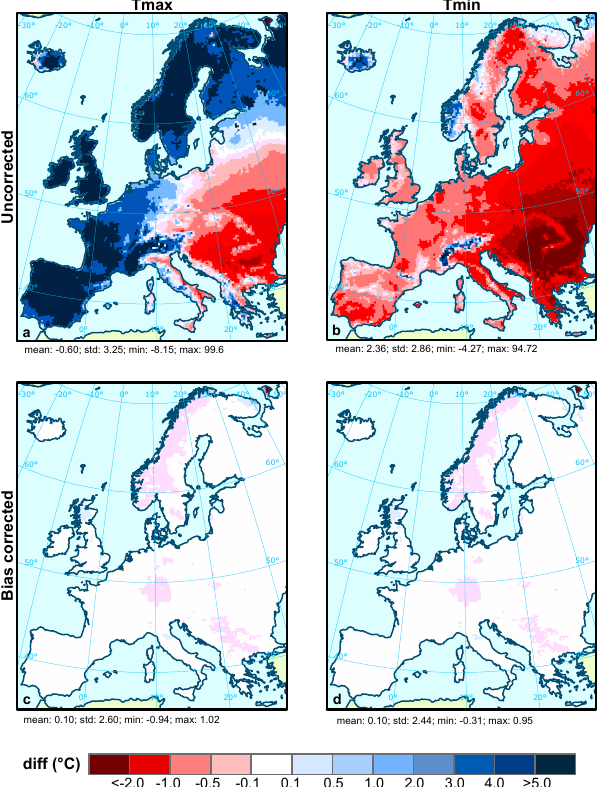
Fig. 7. Differences for daily maximum ( T max ) and minimum ( T min ) temperature simulated by HIRHAM5-ECHAM5 and the E-OBS data set for the control period 1961–1990. First row, uncorrected annual temperature; second row: bias corrected annual temperature.